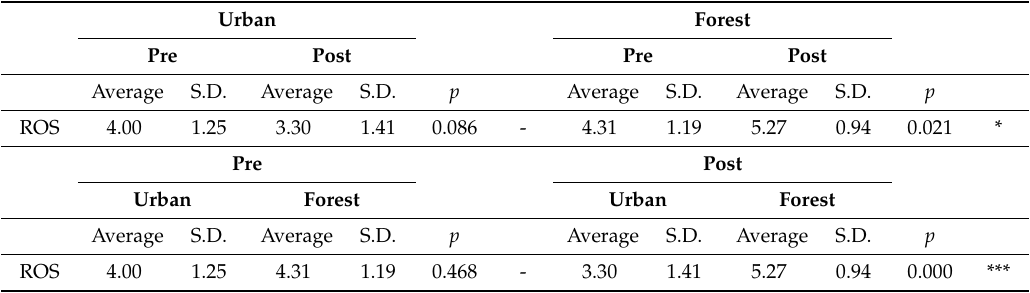
Table 9. Results for mixed-model ANOVAs investigating Subjective Vitality Scale (SVS) scores. Main E ff ect Interaction Conditions: Urban vs. Forest Time: Pre vs. Post Conditions × Time SVS F p η 2 F p η 2